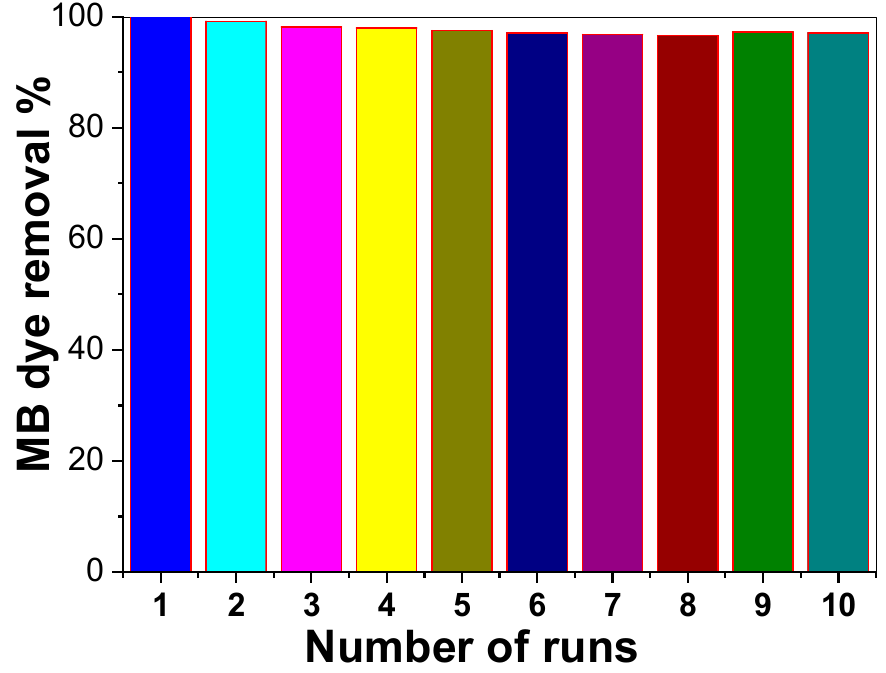
Figure 7. The reusability of 75 mg of Fe 2 O 3 ‐ zeolite photocatalyst for degradation 10 mg/L of MB for 10 runs at pH 7 for 30 s.